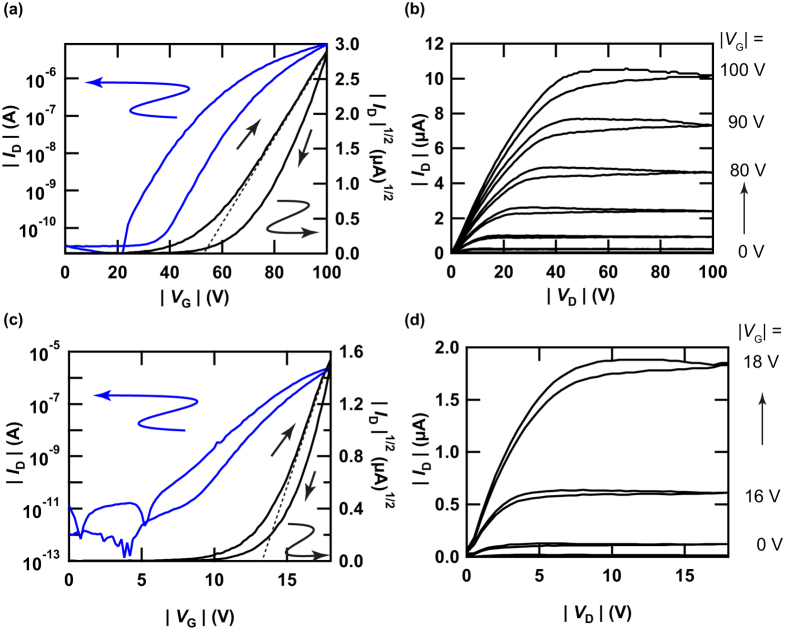
(a) Transfer and (b) output curves for a thin-film FET of 3 with SiO2 gate dielectric. (c) Transfer and (d) output curves for a thin-film FET of 3 with ZrO2 gate dielectric.